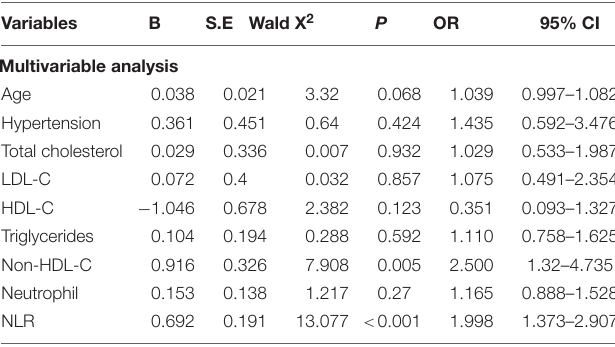
TABLE 2 | Multifactorial logistic regression analysis of coronary artery vulnerable plaques in T2DM